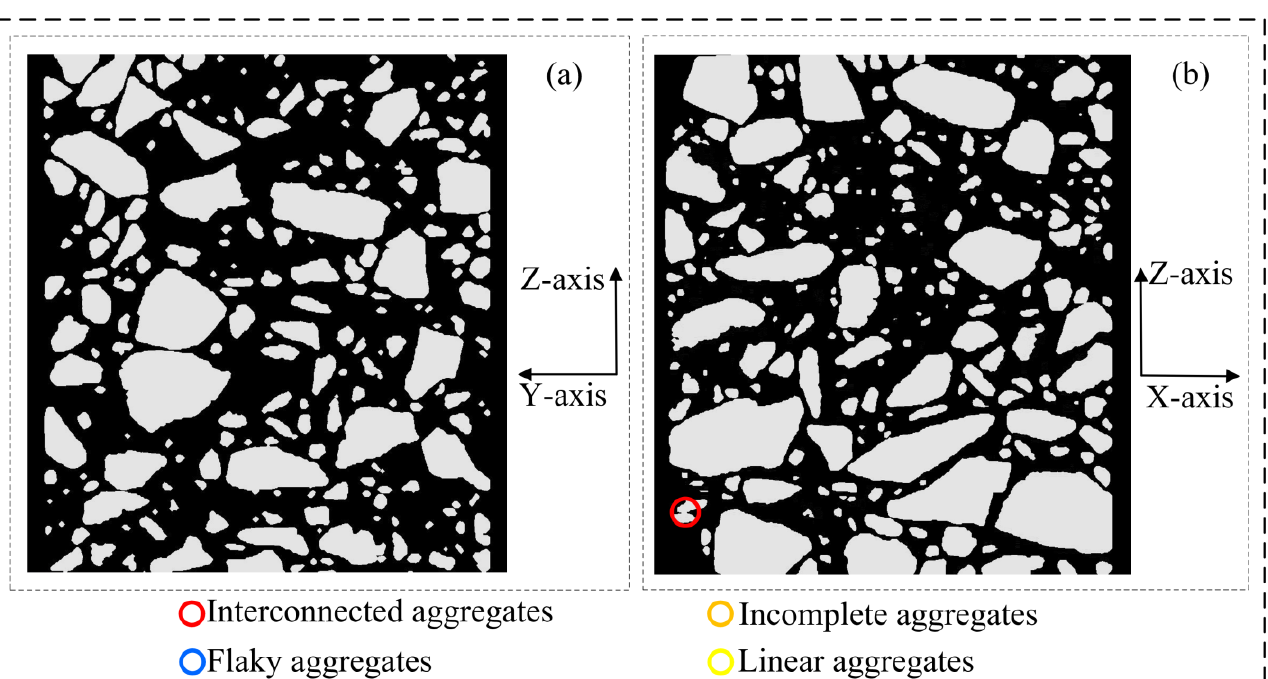
Figure 15. Asphalt concrete 3D voxel model sections (corresponding to Figure 10d): ( a ) YZ section; ( b ) XZ section.